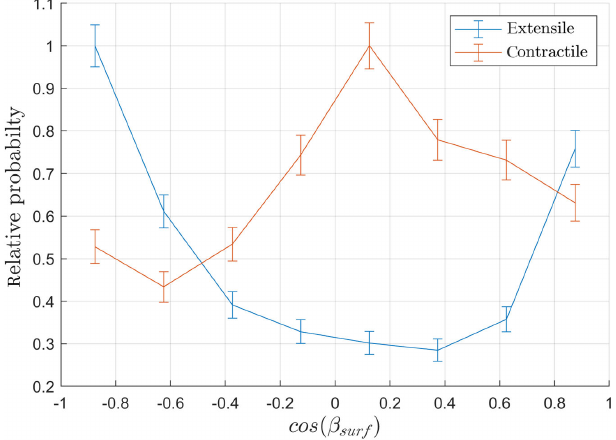
FIG. 4. Distribution of twist angles of surface defects β at positions where disclination lines intersect the droplet inter- face, obtained from a time average in the active turbulent regime. Surface defects are preferentially wedgelike (twistlike) in ex- tensile (contractile) systems where active anchoring favors in- plane (normal) director alignment. The relative probability is given by N i = max ðf N i gÞ , where N i is the number of observations in bins of range X i (cid:3) h= 2 , and error bars denote the bin error ffiffiffiffiffi p N = max ðf N i i gÞ . The averaging is performed over time steps, which is much longer than the average time it takes for a disclination line to move across the droplet τ